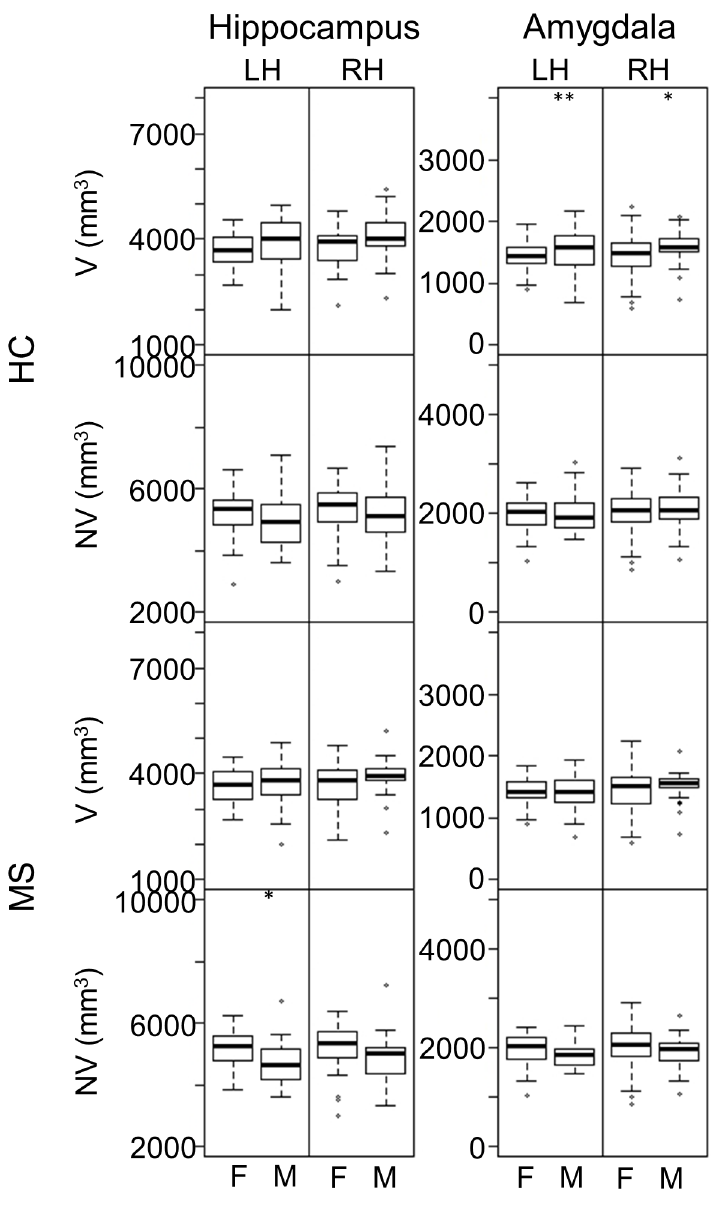
Fig 2. Gender comparisons for V and NV of hippocampus and amygdala in each hemisphere in HC (A–H) and MS (I–P) groups. Panelswith p-values (with FDR correction) (cid:20) 0.05 and > 0.01 are marked with “ * ”. Panels with p-values(with FDR correction) (cid:20) 0.01 are marked with “ ** ”. F = Female; M = Male; LH = Left Hemisphere; RH = Right Hemisphere.